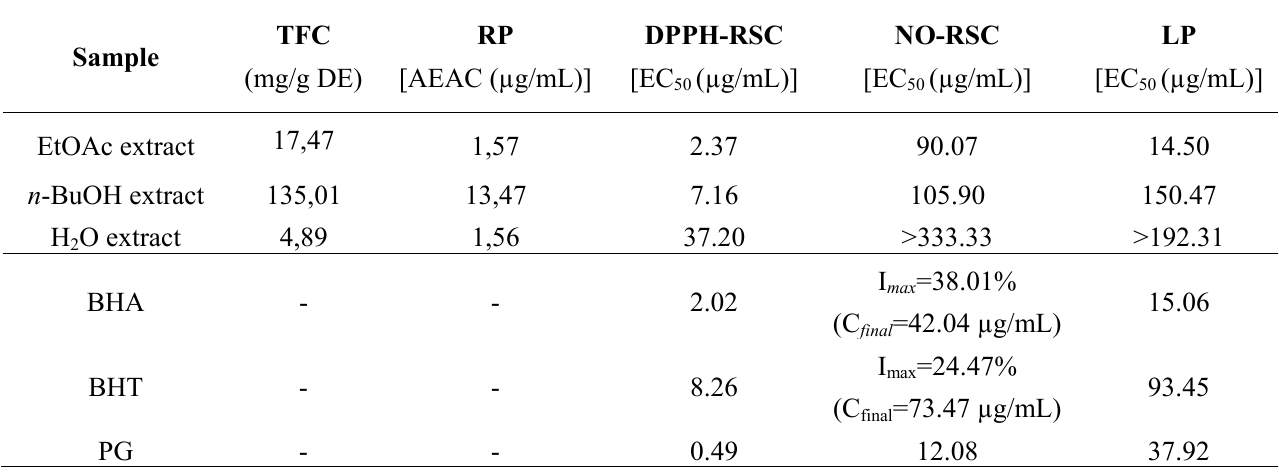
Table 2. Total flavonoid content, reducing power and antioxidant activity (DPPH-RSC, NO-RSC, LP) of examined E. arvense extracts and synthetic antioxidants (BHA, BHT and